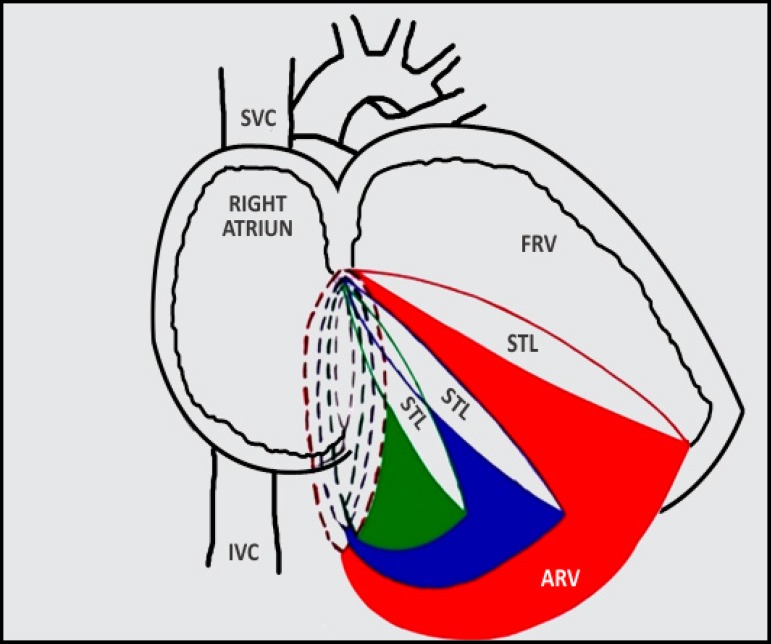
Schematic representation of severity of Ebstein's anomaly. As the
displacement of septal tricuspid leaflet increases, there is a
corresponding increase in true tricuspid annulus dilatation and a
decrease in the amount of functional right ventricle. Broken lines
indicate true tricuspid annulus. Coloured region indicates the thinned
out atrialized right ventricle. Black - normal; green - mild dilatation;
blue - moderate dilatation; and red - severe dilatation.